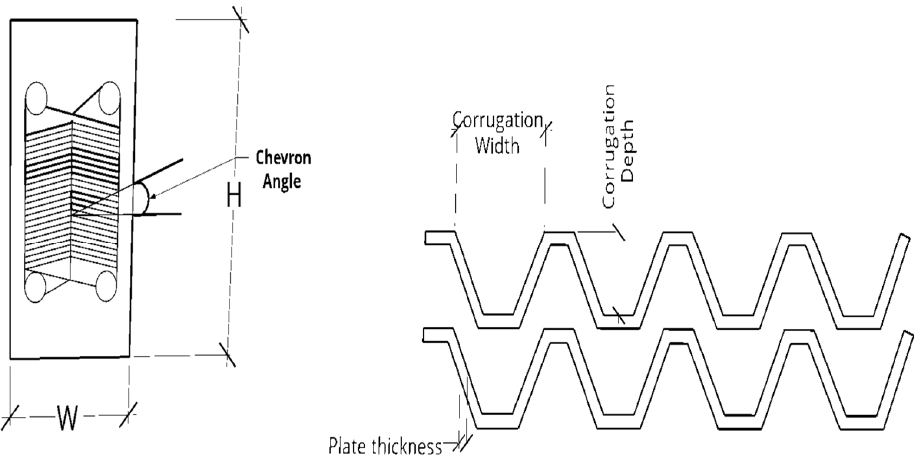
Figure 5. Representative schematic view of the plate heat exchanger.